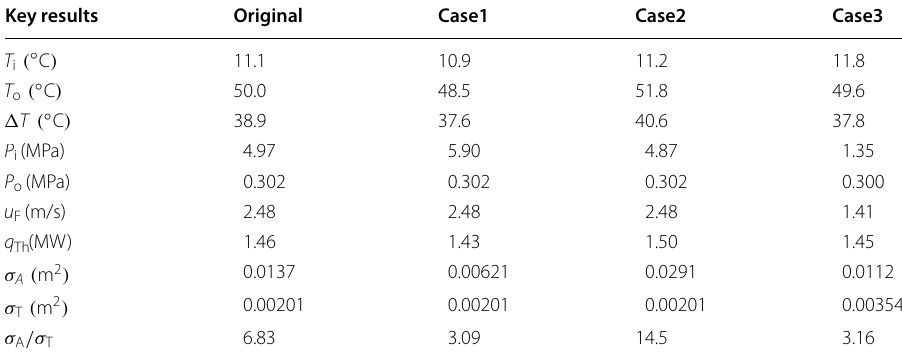
Table 11 Key results when varying annulus with original radii dimensions to